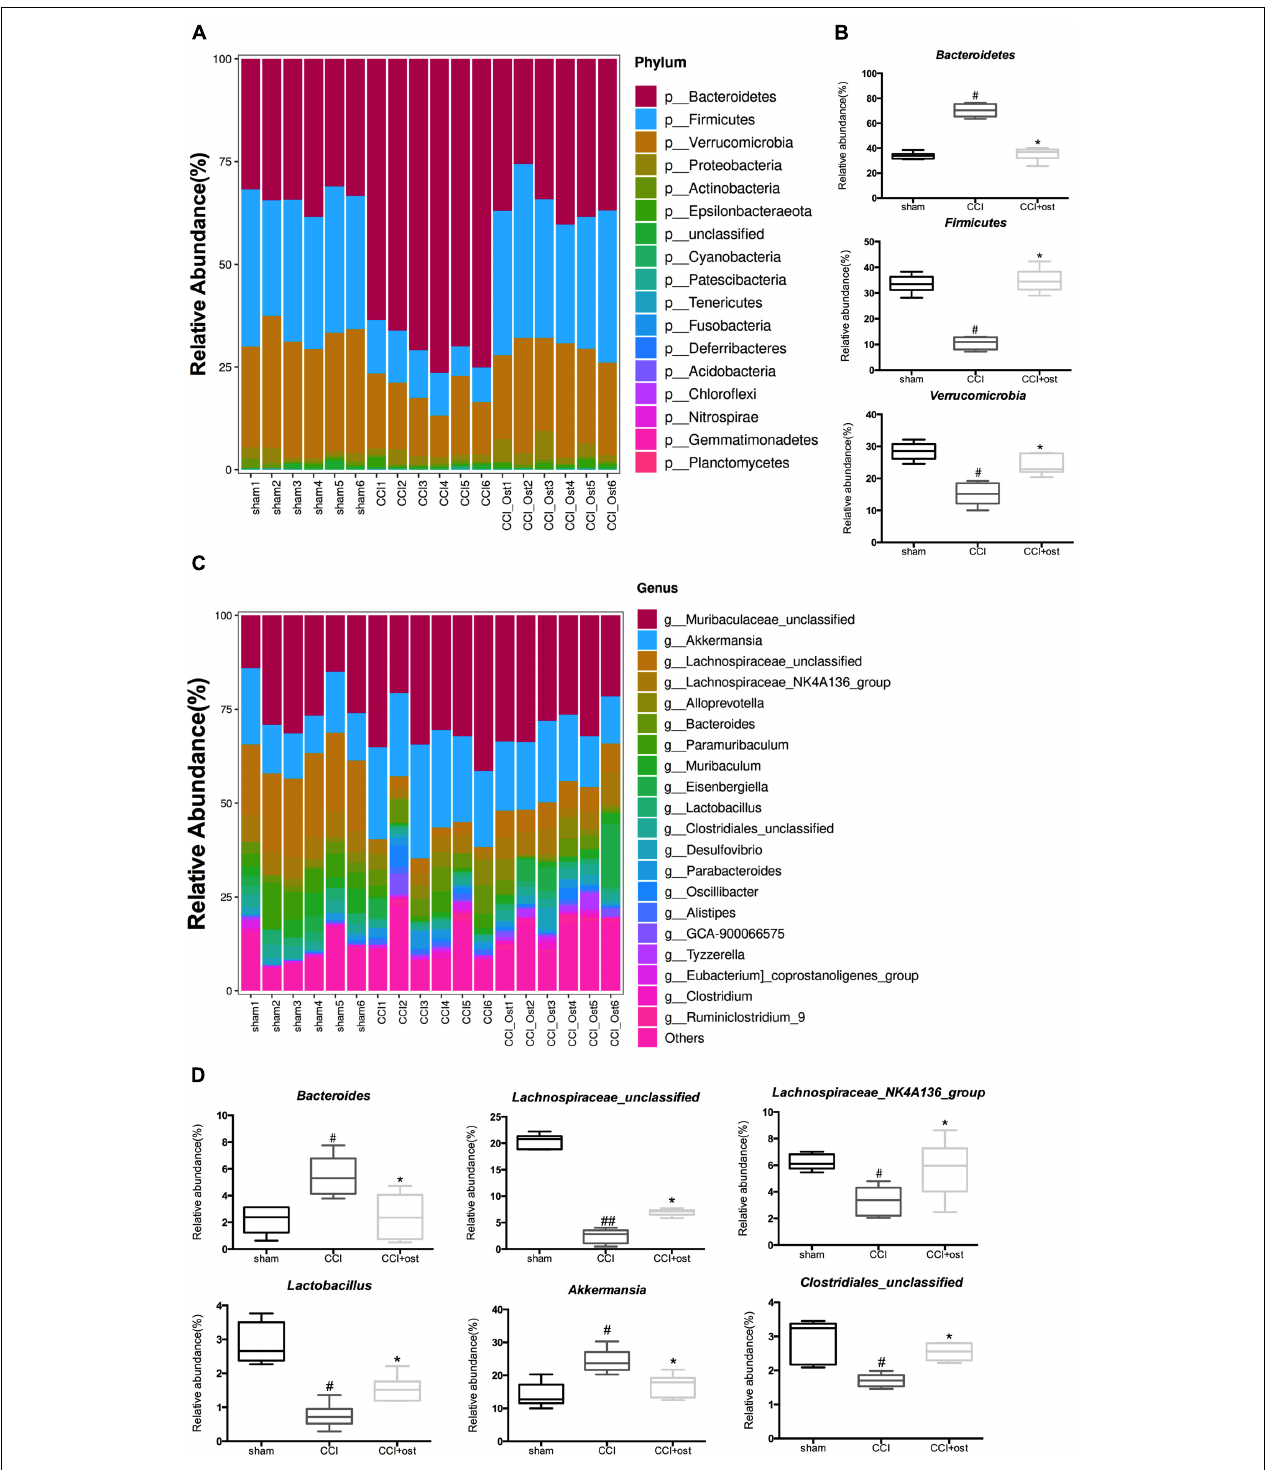
FIGURE 3 | Effects of osthole on the structure of gut microbiota. Based on the quantitative data, the relative abundance of gut microbiota was displayed in a stacked bar plot, including the dissimilarity of gut microbiota in phyla level (A) and in phyla level (C) . (B) The gut microbiota differed significantly among the groups in phyla level (B) and in phyla level (D) . ## p < 0.01, # p < 0.05 compared with sham group; * p < 0.05, compared with chronic constriction injury (CCI) group, analysis of variance (ANOVA) followed by Bonferroni post-hoc test, n = 6 mice/group.